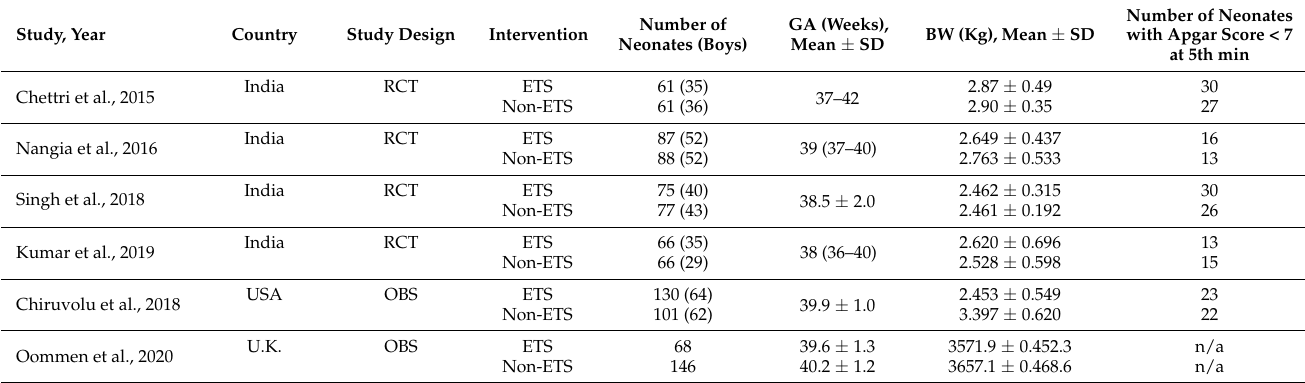
Table 1. Studies and patients’ characteristics per study (in ascending chronological